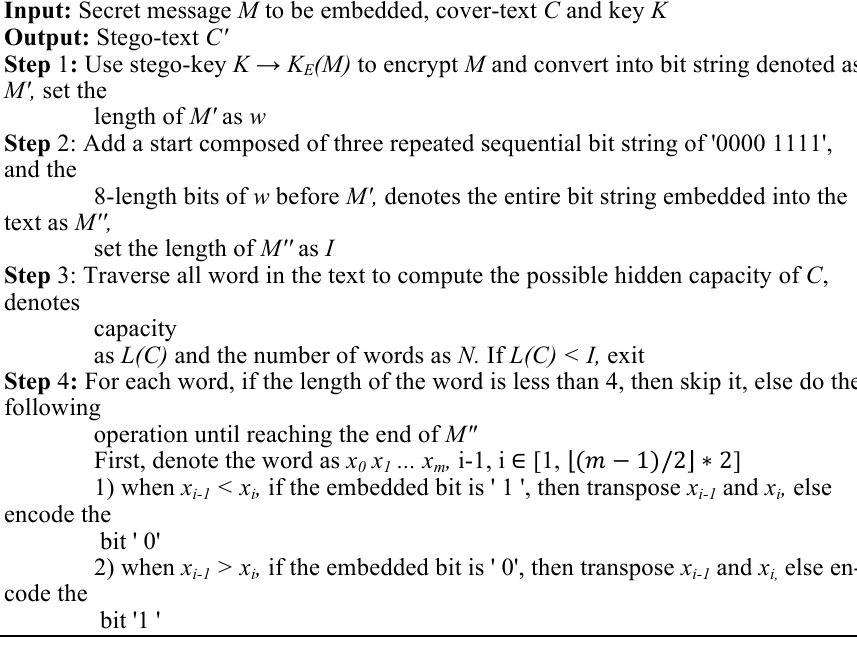
Fig. 1. Embedding Algorithms